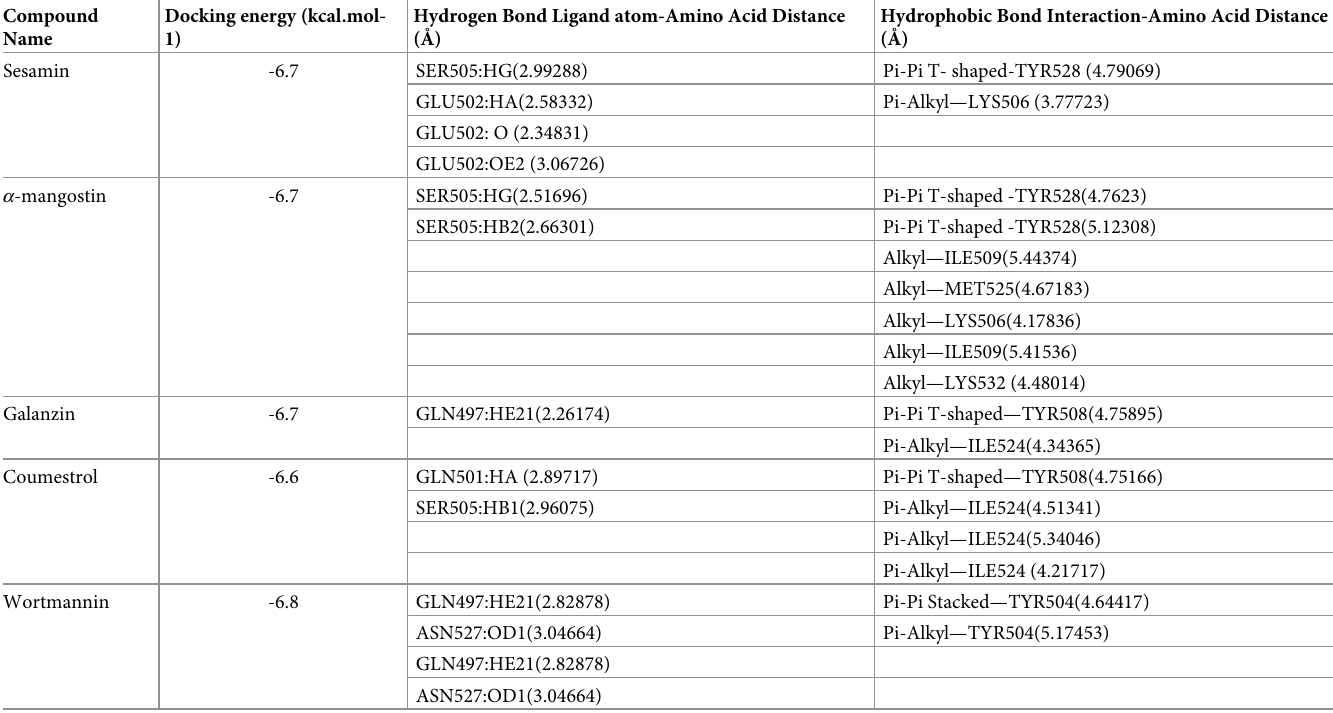
Table 5. Docking simulation results of 4 compounds with docking score energy and interaction with amino acids against PIK3R1